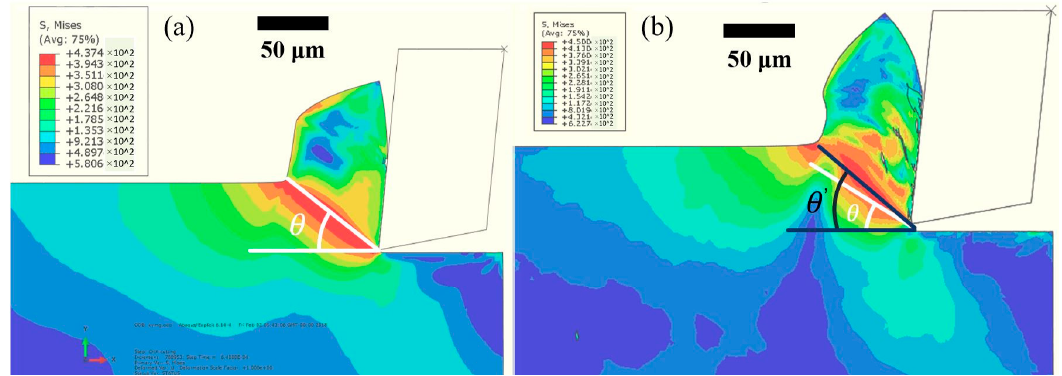
Figure 16. FE results of shear angle. ( a ) Conventional micro milling, ( b ) vibration-assisted micro milling with tool-workpiece separation.